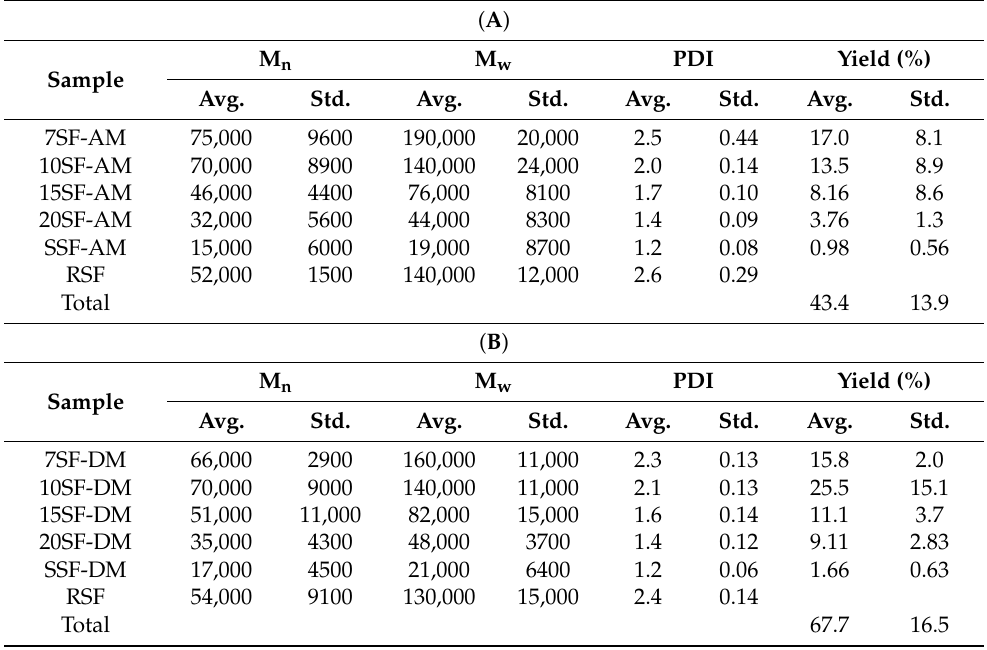
Table 1. Number-averaged molecular weight (M n ), weight-averaged molecular weight (M w ), poly- mer dispersion index (PDI) and yield ratios of precipitation at fractionation. Fractionation was repeated three times: (A) AM and (B)